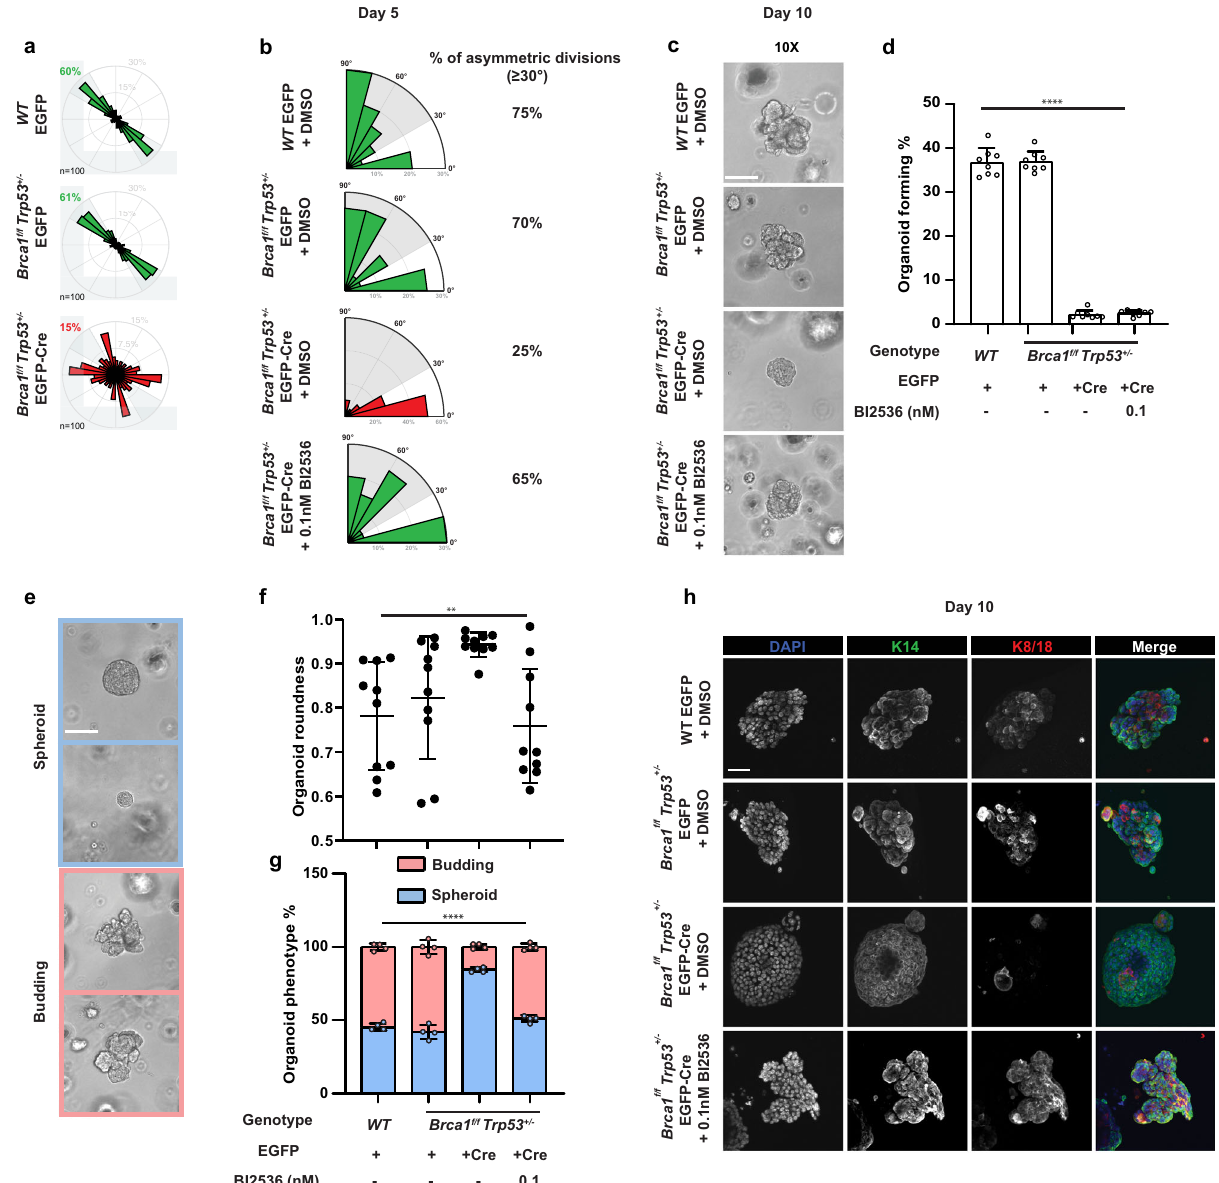
Fig. 7 Cre-driven Brca1 mutation alters organoid structures in a PLK1-dependent manner. a Distribution of cell division angles in 10°-wide sectors measured at anaphase for Brca1 + / + ;Trp53 + / + or Blg-Cre;Brca1 f/f ;Trp53 + / − murine mammary epithelial cells (MECs) transduced with EGFP or EGFP-Cre lentivirus ( n = 50 cell divisions per experiment, duplicate experiments). b Distribution of cell division angles in 30°-wide sectors measured in day 5 organoids generated from Brca1 + / + ;Trp53 + / + or Blg-Cre;Brca1 f/f ;Trp53 + / − murine MECs transduced with EGFP or EGFP-Cre and treated with DMSO or 0.1 nM BI2536. Angles <30° considered as parallel, symmetric divisions while angles ≥ 30° (highlighted in gray) considered as asymmetric divisions ( n = 10 cell divisions per experiment, duplicate experiments). c Bright fi eld images of day 10 organoids generated from Brca1 + / + ;Trp53 + / + or Blg-Cre;Brca1 f/f ;Trp53 + / − murine MECs transduced with EGFP or EGFP-Cre and treated with DMSO or 0.1 nM BI2536. Scale bar = 100 μ m. d Organoid forming percentage measured at day 10 and generated from Brca1 + / + ;Trp53 + / + or Blg-Cre;Brca1 f/f ;Trp53 + / − murine MECs transduced with EGFP or EGFP-Cre and treated with DMSO or 0.1 nM BI2536 (mean ±SD, n = 4 fi elds imaged per experiment, duplicate experiments). **** P < 1E − 15; one-way ANOVA. e Bright fi eld images of day 10 organoids classi fi ed as spheroid or budding structures. Scale bars = 100 μ m. f Organoid roundness measured at day 10 and generated from Brca1 + / + ;Trp53 + / + or Blg-Cre;Brca1 f/f ;Trp53 + / − murine MECs transduced with EGFP or EGFP-Cre and treated with DMSO or 0.1 nM BI2536 (Violin plot, n = 5 organoids imaged per experiment, duplicate experiments). ** P = 0.0042; one-way ANOVA. g Organoid phenotype percentage measured at day 10 and generated from Brca1 + / + ;Trp53 + / + or Blg-Cre;Brca1 f/f ;Trp53 + / − MECs transduced with EGFP or EGFP-Cre and treated with DMSO or 0.1 nM BI2536 (mean± SD, n = 2 fi elds per experiment, duplicate experiments). **** P = 4.37E − 10; one-way ANOVA. h Immuno fl uorescence analysis of K14 and K8/18 in day 10 organoids generated from Brca1 + / + ;Trp53 + / + or Blg-Cre;Brca1 f/f ;Trp53 + / − murine MECs transduced with EGFP or EGFP-Cre and treated with DMSO or 0.1nM BI2536. Scale bar = 40 μ